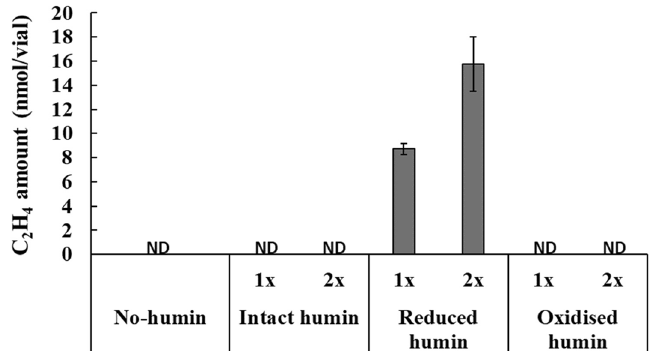
Figure 3. ARA of the no-humin consortium tested with reduced, oxidised and intact humin and without humin. The humin used here was Kamajima humin. Humin concentration was set at two levels as shown by the symbols “1x” and “2x”, indicating 15 g/L and 30 g/L, respectively. ND not detected.